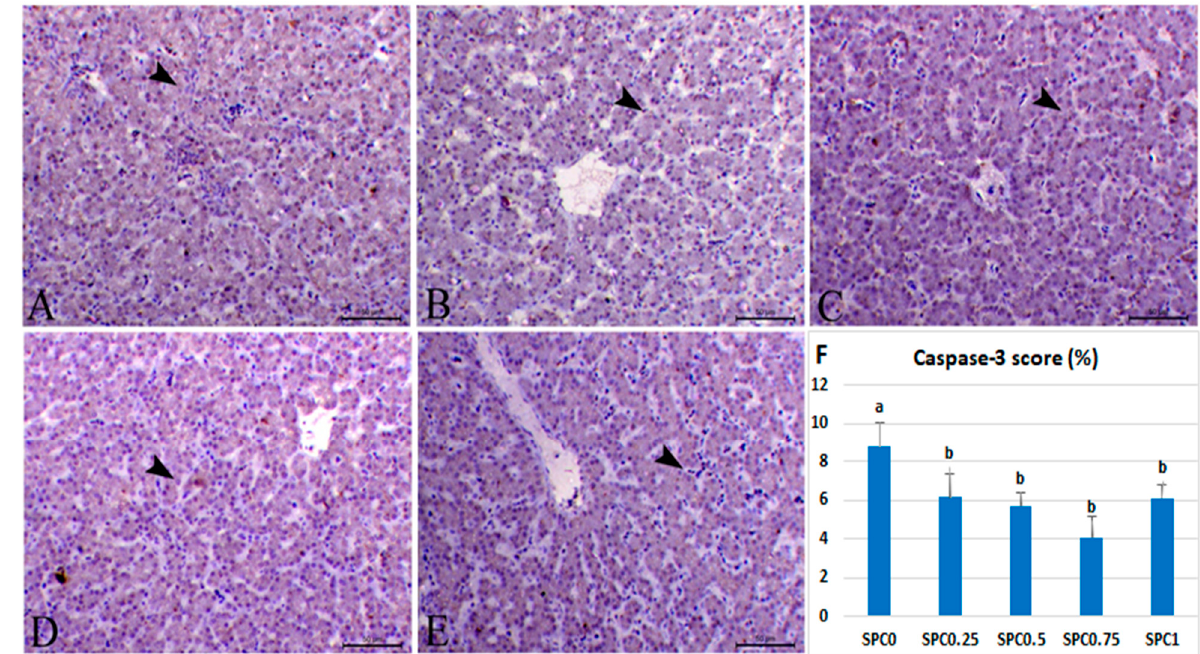
Figure 3. Photomicrograph of hepatic tissues immunostained with caspase-3 antibody. Liver of control basal group showing mild cytoplasmic expression of caspase-3 within hepatocytes ( A ) (arrowhead). Liver of SPC0.25 group showing mild expression of caspase-3 within hepatocytes ( B ) (arrowhead). The liver of the SPC0.5 group showed a decrease in the cytoplasmic immunostaining of caspase-3 within hepatocytes ( C ) (arrowhead). Liver of SPC0.75 group showing mild cytoplasmic expression of caspase-3 within hepatocytes ( D ) (arrowhead). Liver of SPC1 group showing mild cytoplasmic expression of caspase-3 within hepatocytes ( E ) (arrowhead). Bar = 50 µm. ( F ) shows morphometric measures of caspase-3 immunostaining expression (%). a,b Means carrying different superscripts were significantly different ( p ≤ 0.05) .